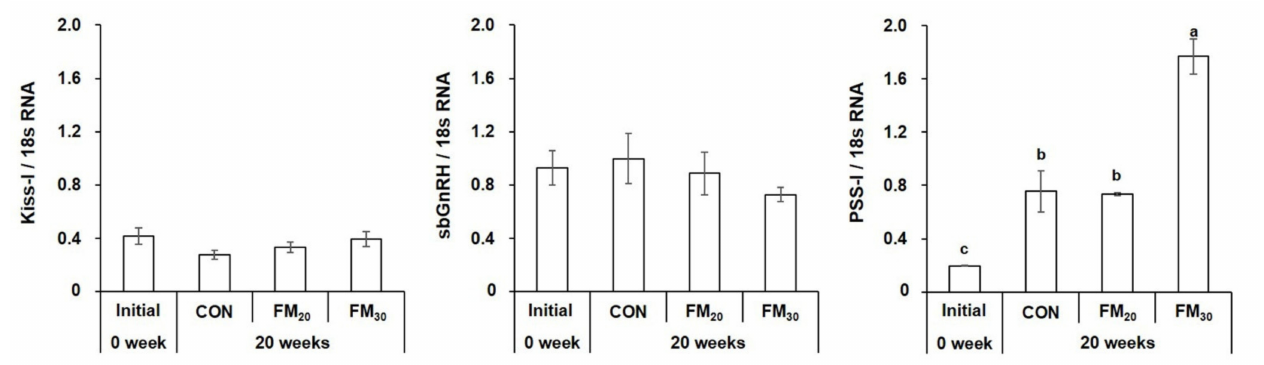
Figure 5. Expression of kisspeptin (Kiss) I, gonadotropin-releasing hormone (sbGnRH), and preprosomatostatin (PSS) I mRNA in the olive flounder Paralichthys olivaceus. Data are presented as the mean ± SEM ( n = 10). Different letters above the bars indicate significant differences ( p < 0.05) between groups. CON, control diet; FM 20 , diet with 20% of the fishmeal replaced; FM 30 , diet with 30% of the fishmeal replaced.